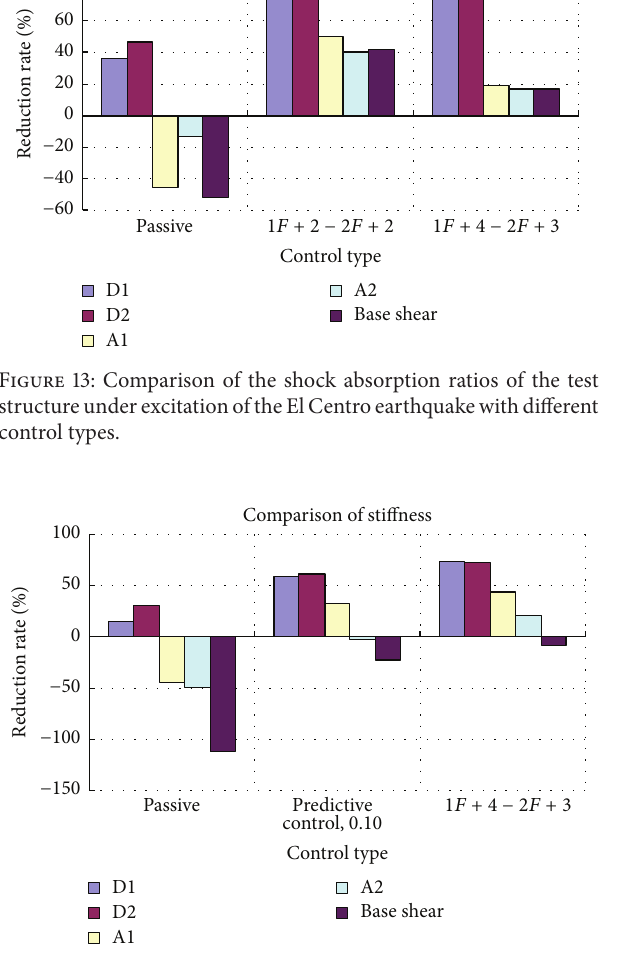
Figure 14: Comparison of shock absorption ratios of the test structure under excitation of the Kobe earthquake with different control